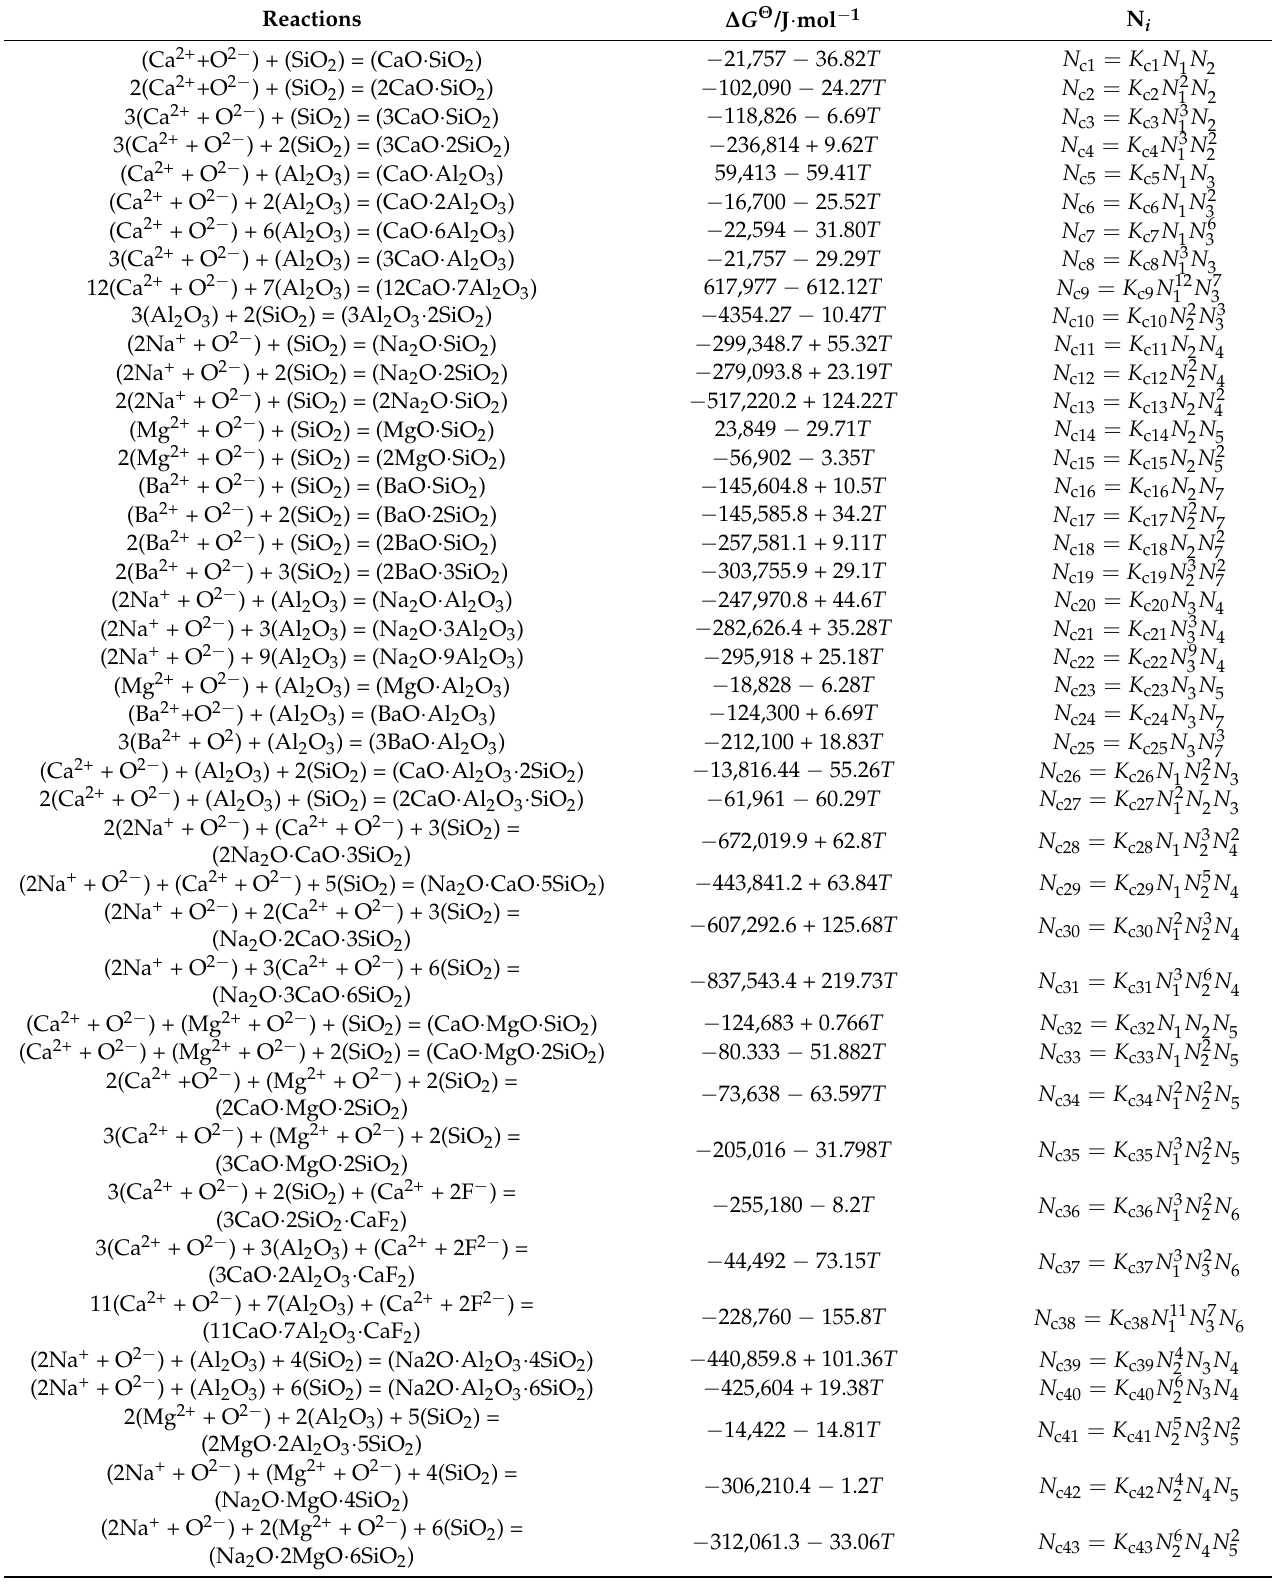
Table 3. Chemical reaction formulas of possibly formed complex